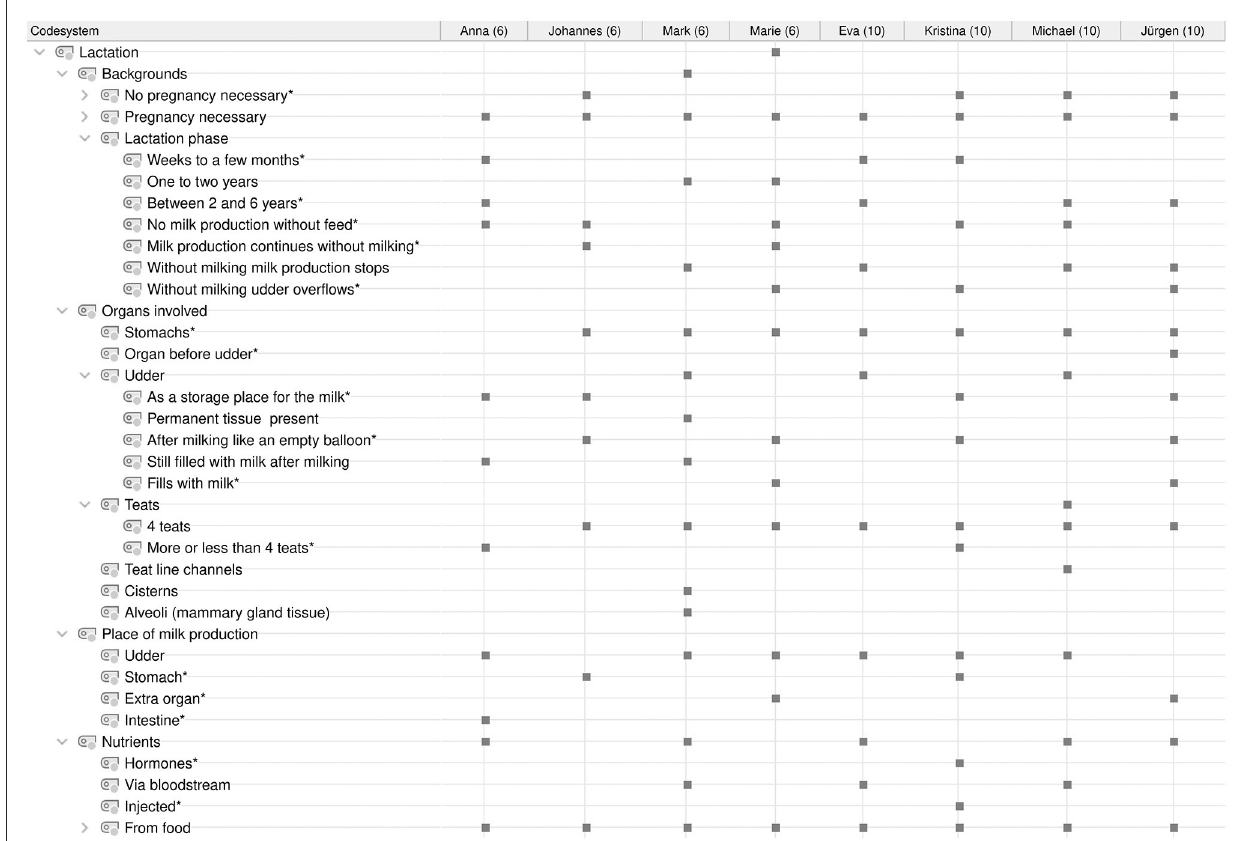
FIGURE8 Overview of the students’ statements on the process of milk formation in a cow. * Inductively coded categories. The marks by the categories indicate that they were named by the student.